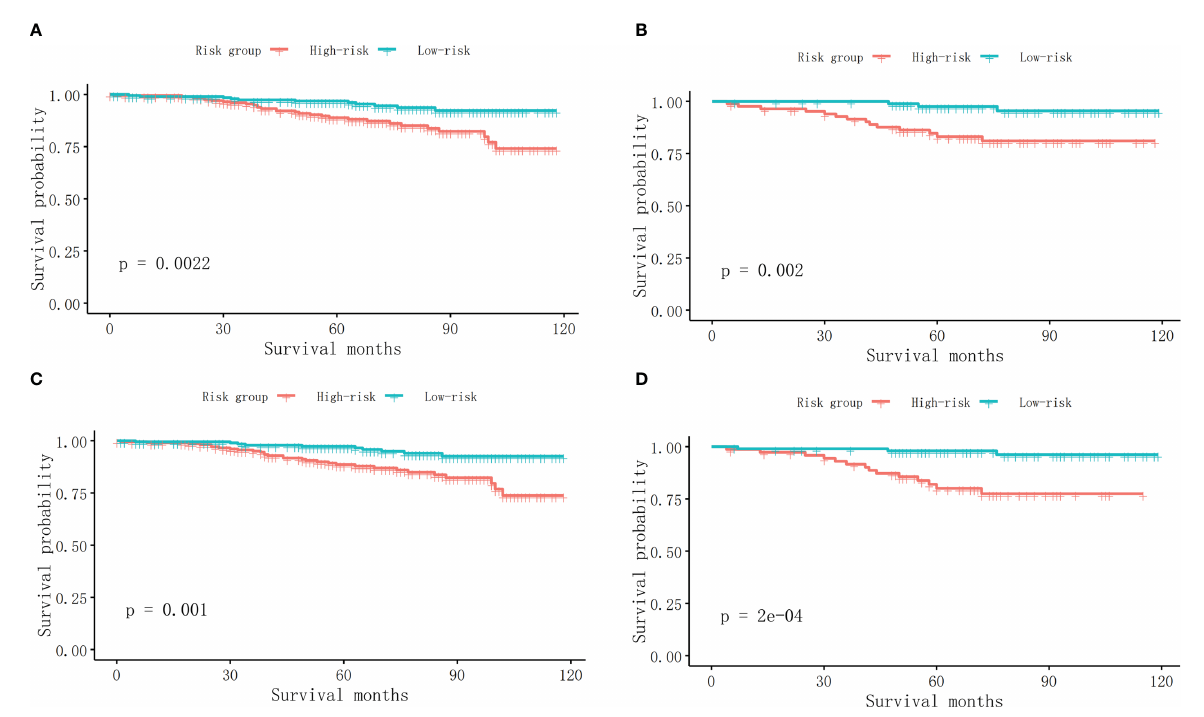
FIGURE 5 (A) The survival curves between different risk groups in the development cohort in model 1. (B) The survival curves between different risk groups in the validation cohort in model 1. (C) The survival curves between different risk groups in the development cohort in model 2. (D) The survival curves between different risk groups in the validation cohort in model 2.